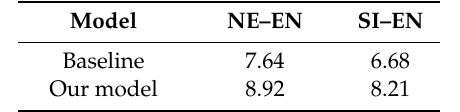
Table 4. The BLEU score of NE–EN and SI–EN translation